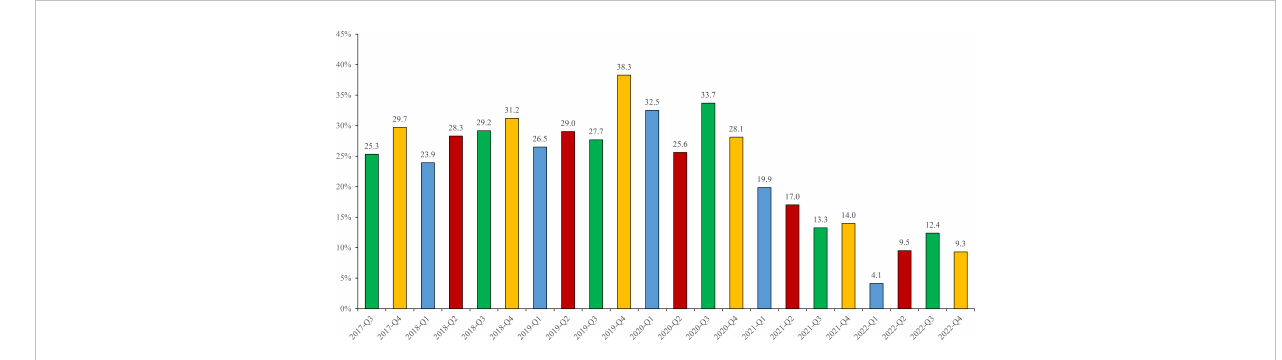
FIGURE 3 EBV-positive ratios in different periods from 2017 to 2022. Different colors represented different quarters: Q1 (blue), Q2 (red), Q3 (green), Q4